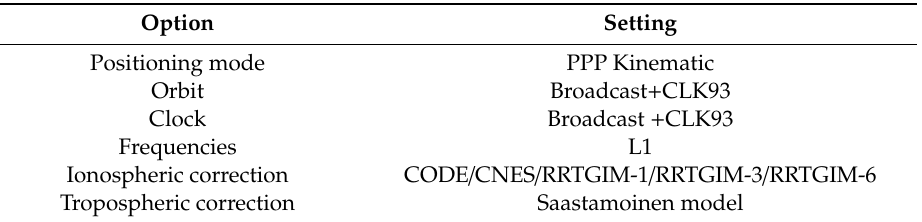
Table 6. Details processing strategies for the SF-PPP solution.